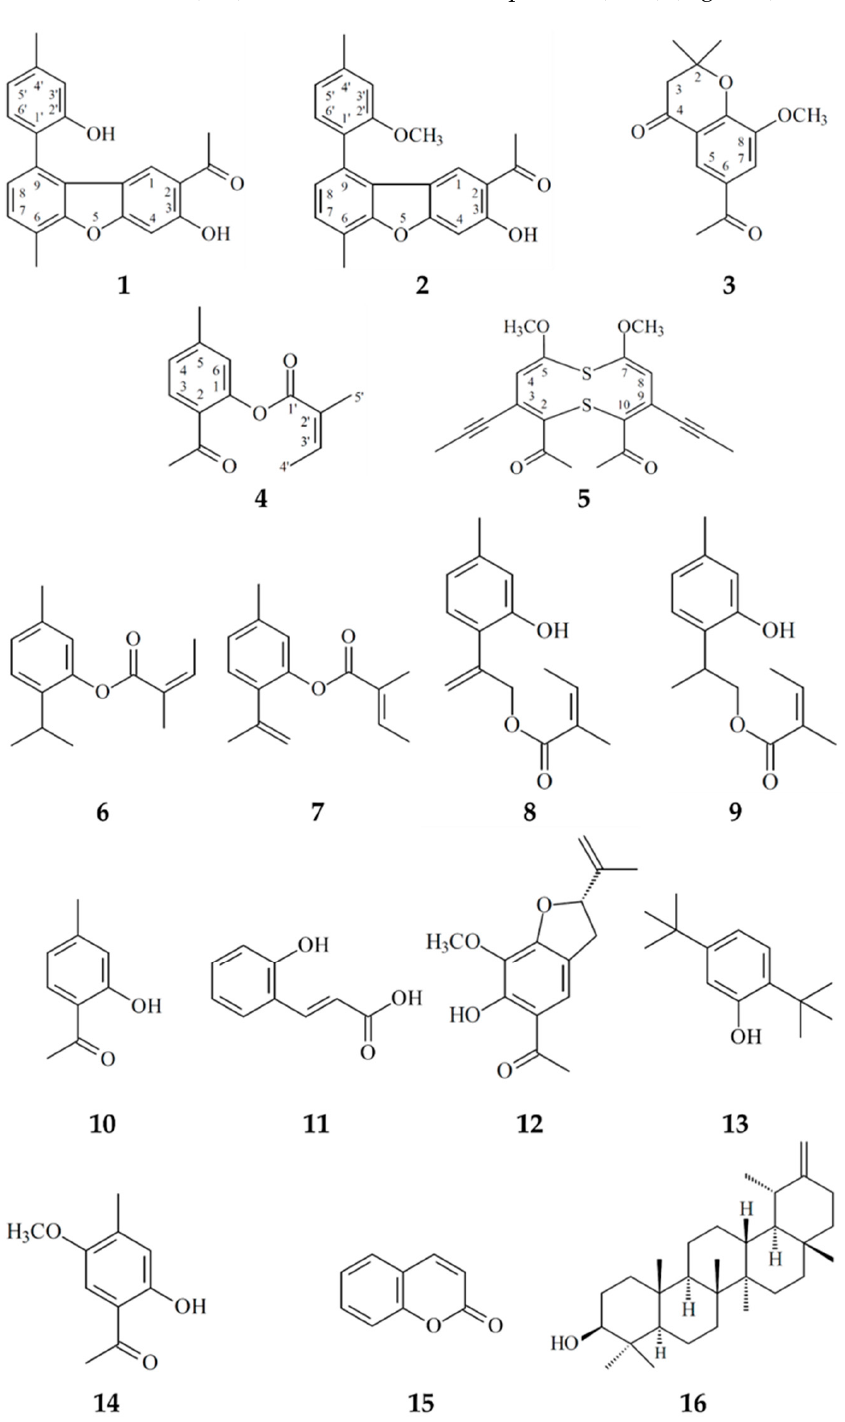
Figure 1. The chemical structures of new compounds 1 – 5 and known compounds 6 – 16 isolated from E. fortunei .